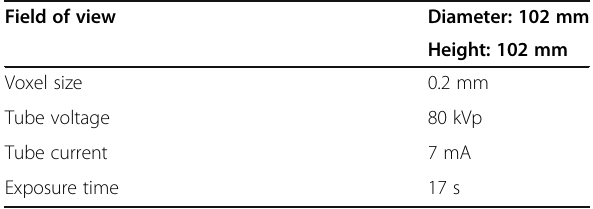
Table 1 Cone-beam computed tomography imaging